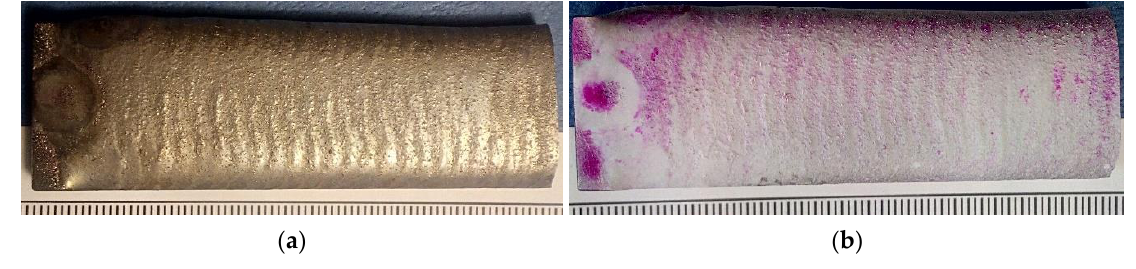
Figure 9. Surface layer made using the Co3+TiC+PD-W composite powder: ( a ) layer after the visual tests (VT) and ( b ) layer after the penetrant tests (PT).